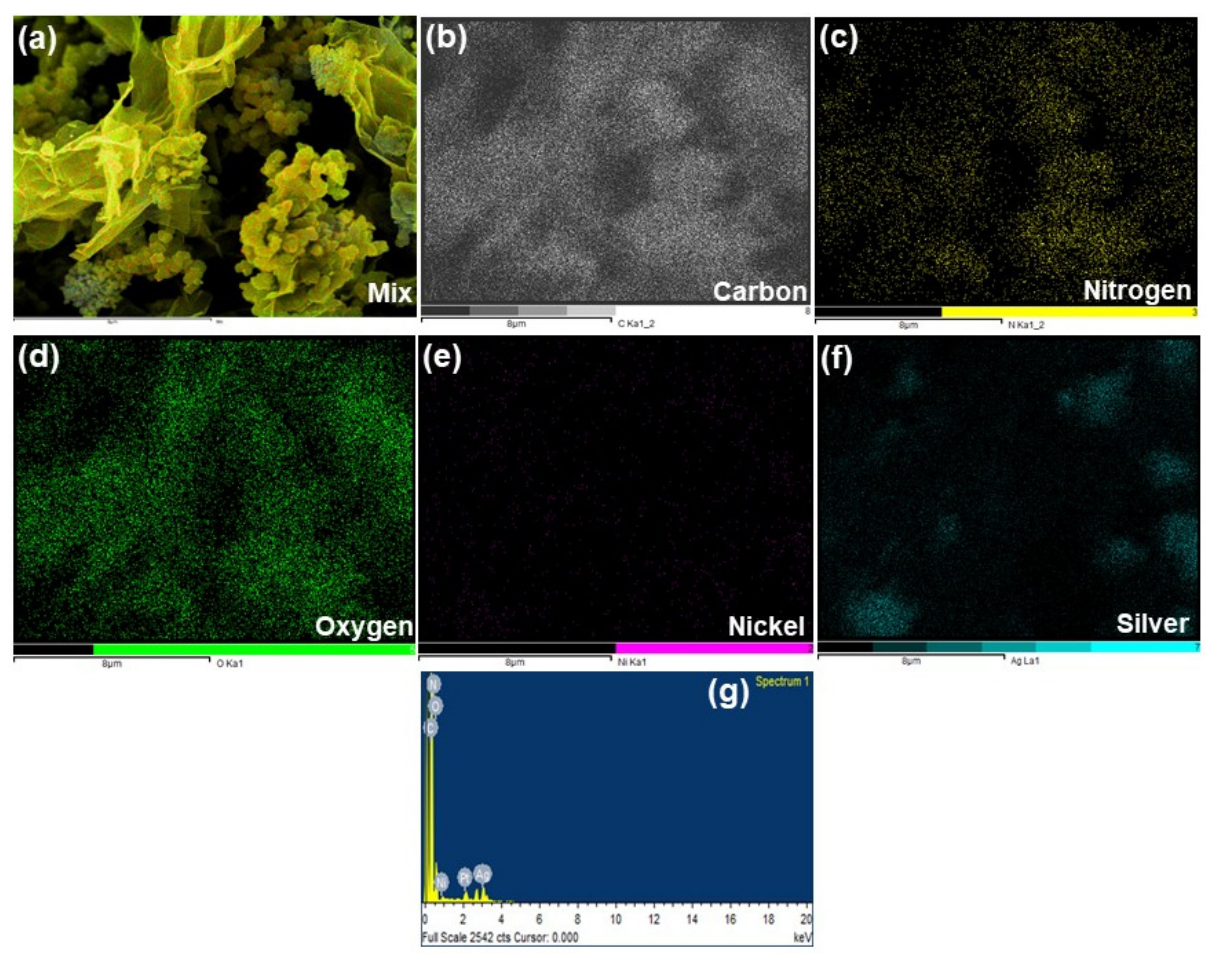
Figure 2. ( a ) Showing the compounded image of EDAX mapping of the quaternary nanocomposite, Ag/GN@PPy–Ni(OH) 2 , ( b ) elemental mapping of carbon contents, ( c ) nitrogen, ( d ) oxygen, ( e ) nickel, ( f ) silver, and ( g ) represents the EDAX graph.